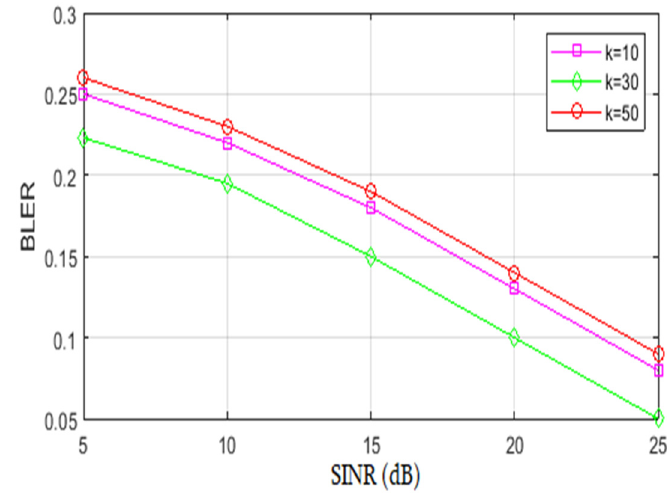
Figure 4. BLER versus SINR for various k values in RLA–KNN.